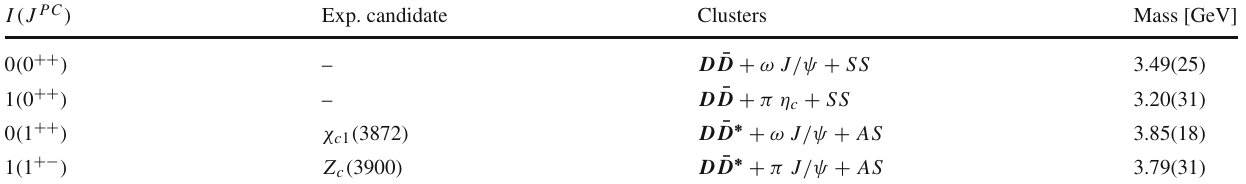
Table 1 Ground state masses for hidden-charm four-quark states with a pair of light quarks. The errors stem from extrapolations of the eigen- value curve on the real axis. Bold-written clusters denote the dominant